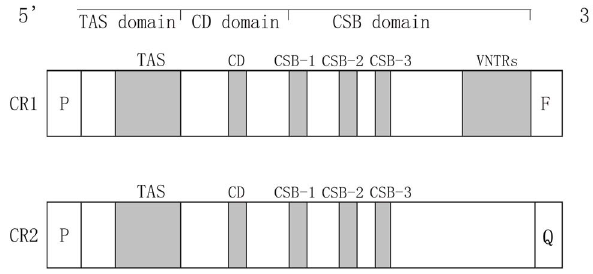
Figure 2. Structures of duplicate CRs in individuals. Three functional regions, TAS, CD, and CSB, were detected in both CRs in all individuals. The core sequences of these regions were found to be identical in CR1 and CR2. Variable numbers of tandem repeats (VNTRs) were detected only in CR1.